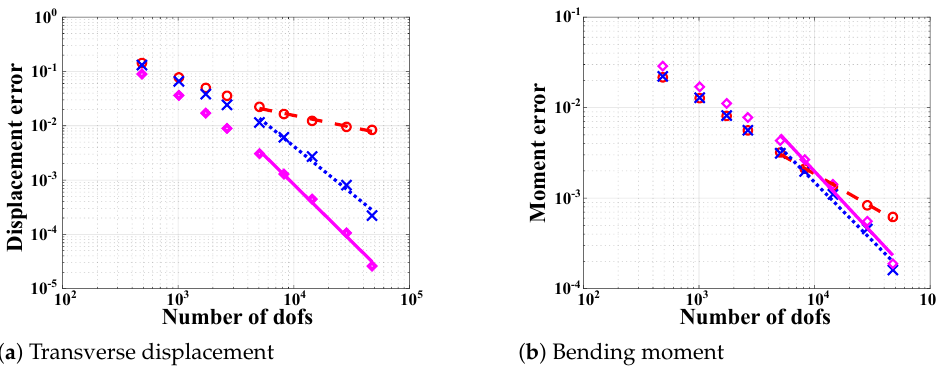
Figure 3. Convergence of the error measures at the middle of the plate versus number of degrees of freedom. ¯ a = 533: dashed line ( ◦ ); ¯ a = 53.3: dotted line ( × ); ¯ a = 16: solid line ( (cid:5)